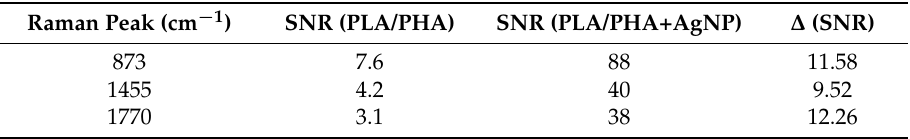
Table 2. Signal-to-noise ratios (SNRs) for PLA/PHA characteristic Raman peaks for PLA/PHA matrix and PLA/PHA+AgNP nanocomposite. ∆ (SNR) depicts the increase in the SNR when the silver is on the